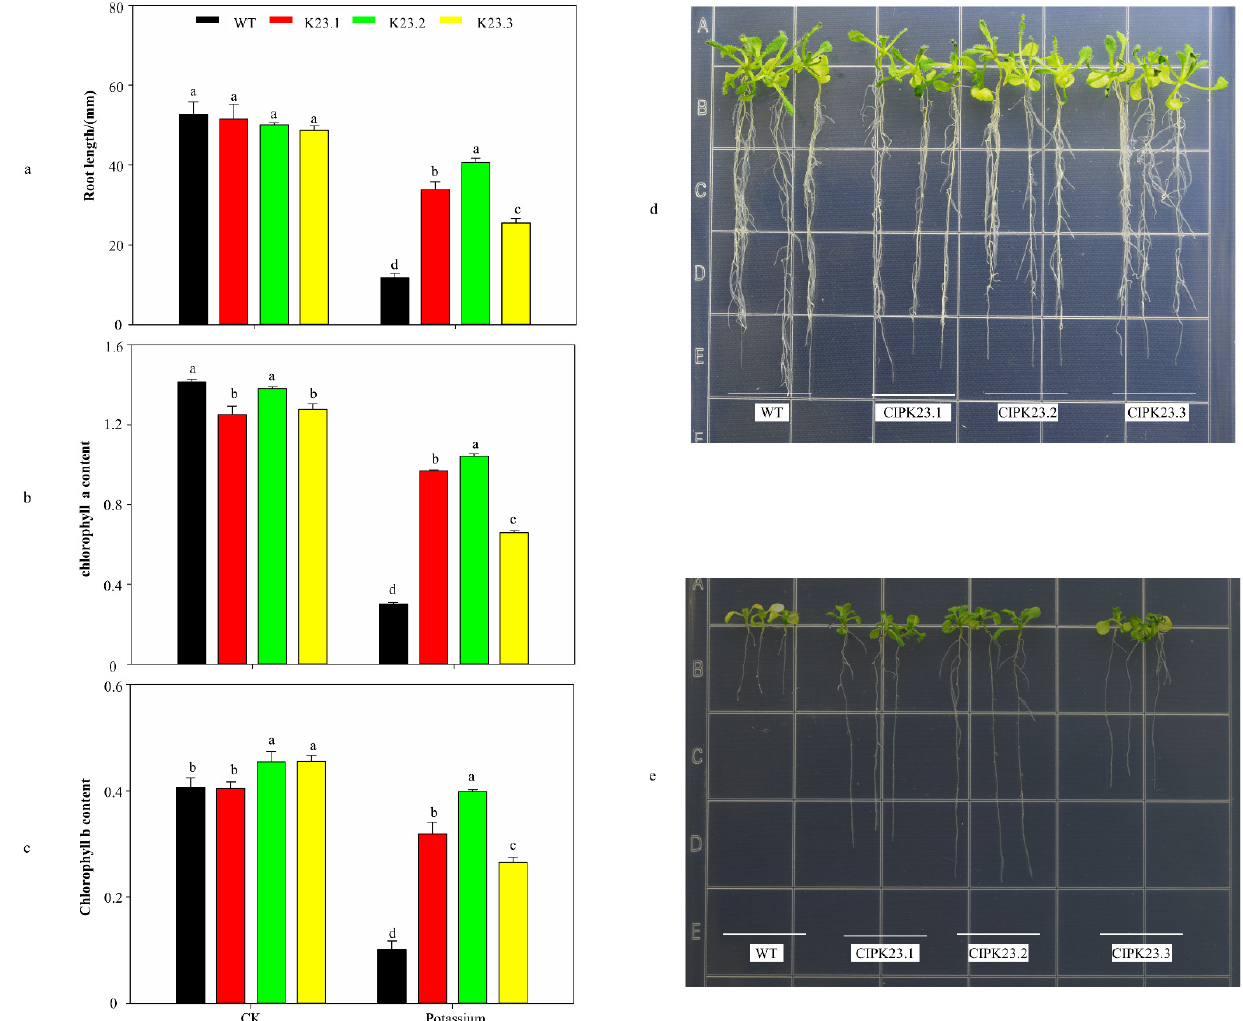
Figure 8. Determination of root length and chlorophyll content and phenotypic observation of trans- BraCIPK23.1/23.2/23.3 A. thaliana ( a ) Comparison of root lengths of transgenic CIPK23.1, -23.2, -23.3 with wild-type A. thaliana on potassium deficient and normal MS mediums. ( b , c ) Comparison of chlorophyll a and chlorophyll b content in leaves of transgenic CIPK23.1, -23.2, -23.3, and wild-type A. thaliana under potassium deficient and normal MS mediums. ( d ) Comparison of phenotypes of transgenic CIPK23.1, -23.2, -23.3 A. thaliana with wild-type A. thaliana under normal MS mediums. ( e ) Comparison of phenotypes of transgenic CIPK23.1, -23.2, -23.3 A. thaliana with wild-type A. thaliana under potassium